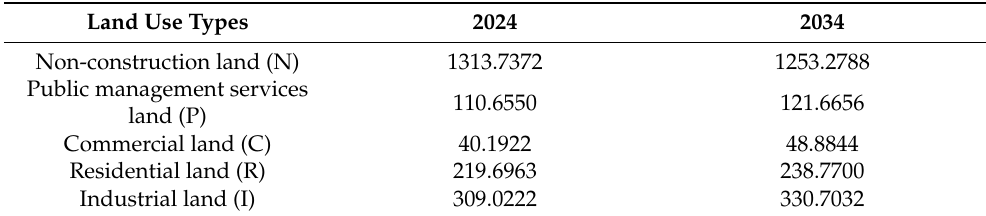
Table 3. Total simulated area (km 2 ) of each land use type under future years.